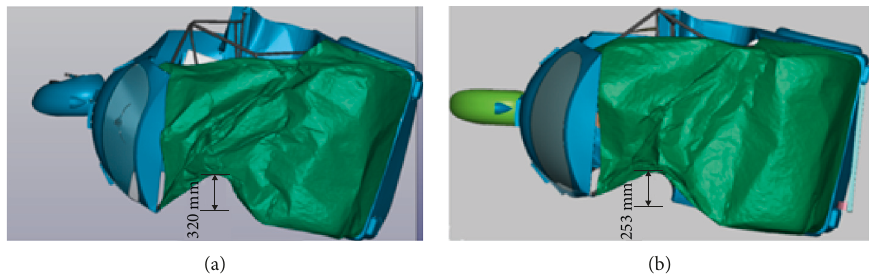
Figure 18: TWV structural response: (a) existing and (b) modified.